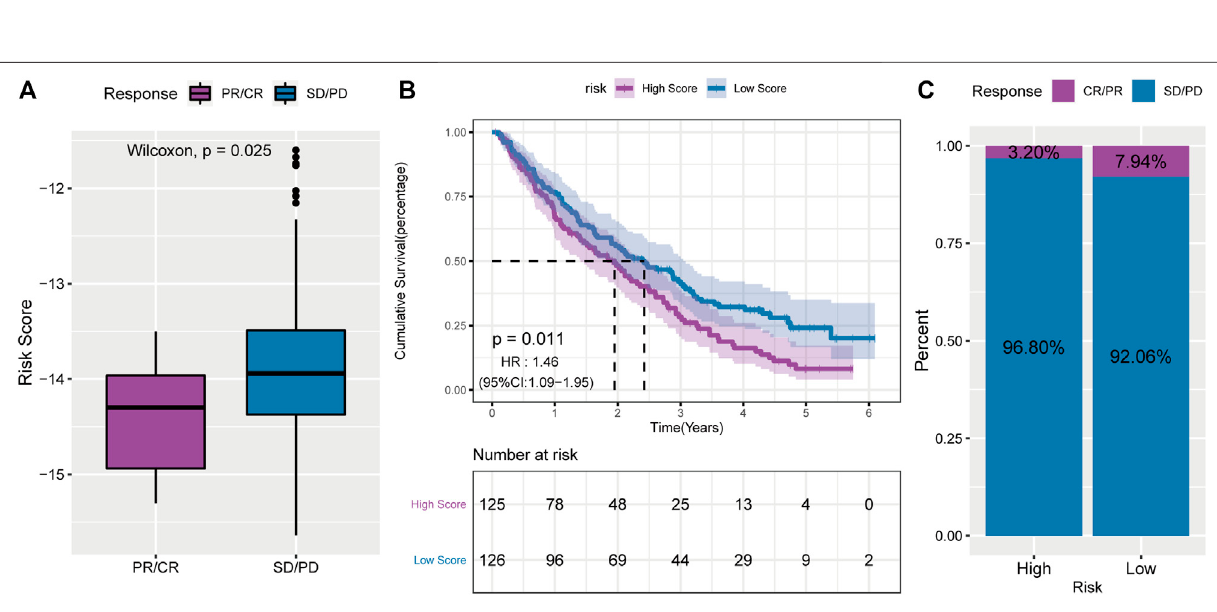
FIGURE 11 | A powerful role of the PS-score scoring model in PD-1 blocking immunotherapy. (A) : comparison of risk scores of non-responsive group in PD-1 blockingtherapycohort; (B) :survivalcurveofhighandlowriskscoregroupsinPD-1blockingtherapycohort; (C) :proportionofpatientswithhighandlowriskscorewho respond to PD-1 blocking therapy.